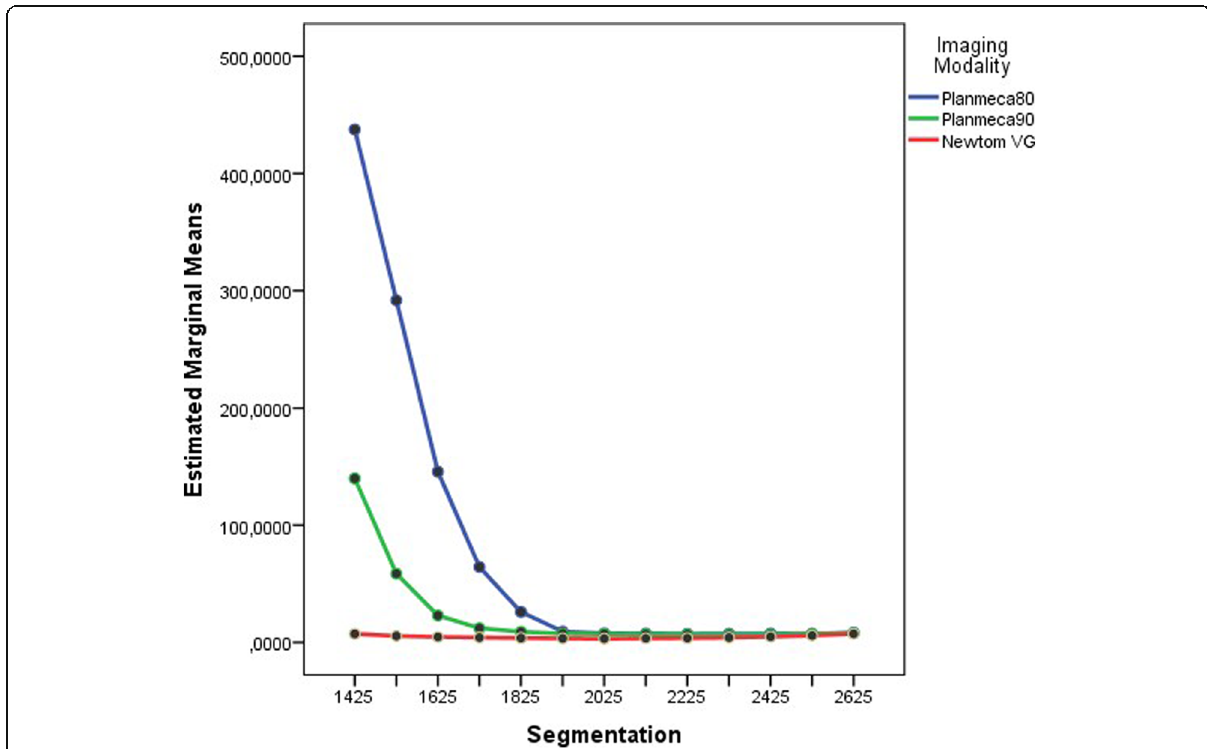
Fig. 2 A plot of the threshold values used for the segmentation of the stone models against the marginal means of the Dissimilarity Index for the different imaging modalities. An interaction between the imaging modalities and the segmentation value for the production of the error can be